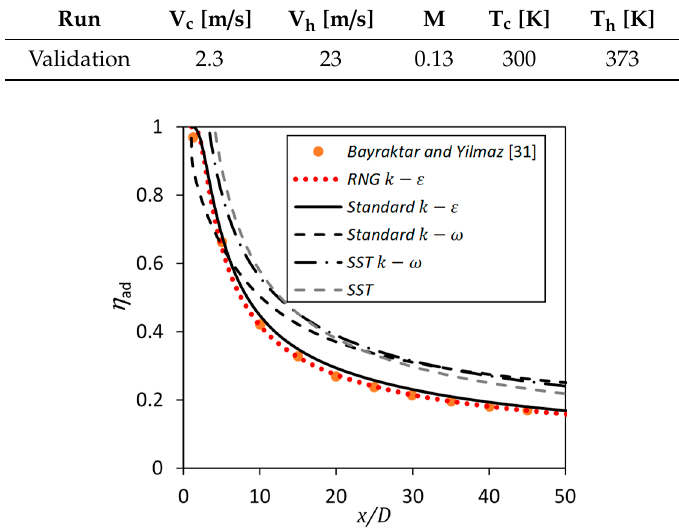
Figure 4. Turbulence model selection based on the validation case in Table 1 versus against numerical study of Bayraktar and Yilmaz [31].